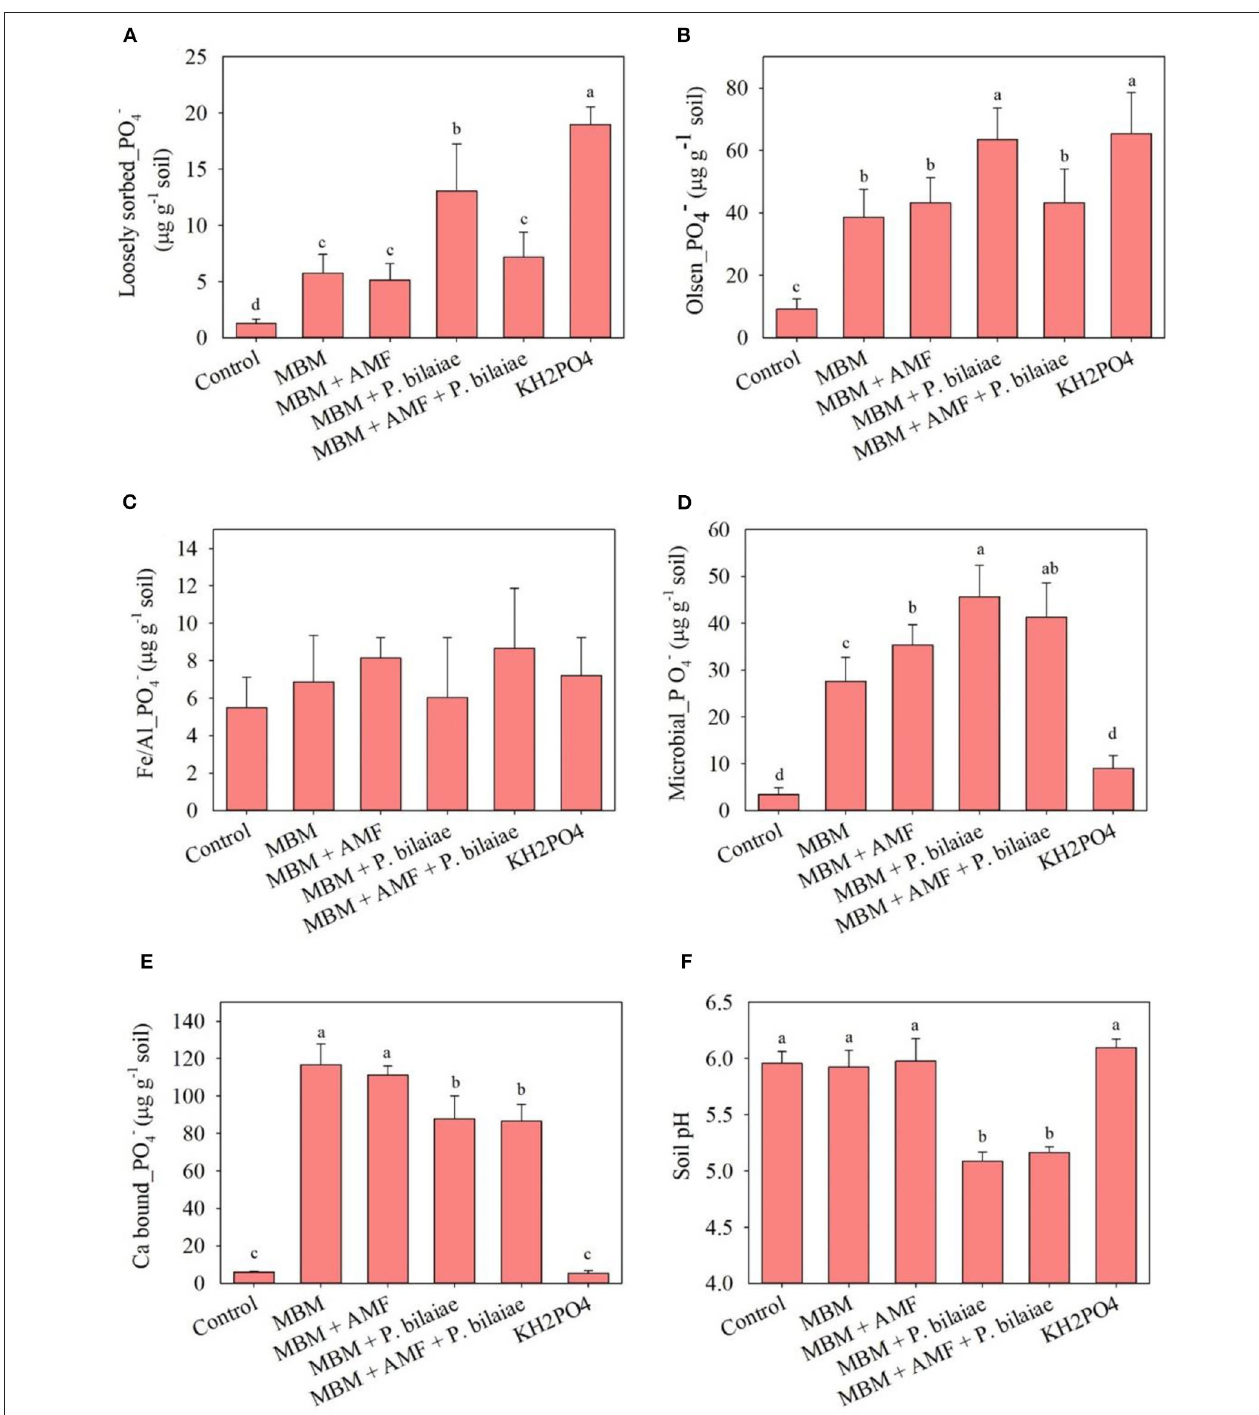
FIGURE 6 | Mineral P forms, loosely sorbed P (A) , olsen P (B) , Fe/Al bound P (C) , microbial biomass P (D) , Ca bound P (E) , and soil pH (F) as affected by different P fertilizers and P mobilizers (arbuscular mycorrhizae fungi (AMF) and P. bilaiae ) at 40 days after planting. Different alphabetical letters signify the statistical difference (Tukey test, p < 0.05) across the treatments. Error bar represents the mean ± SD ( n = 5).